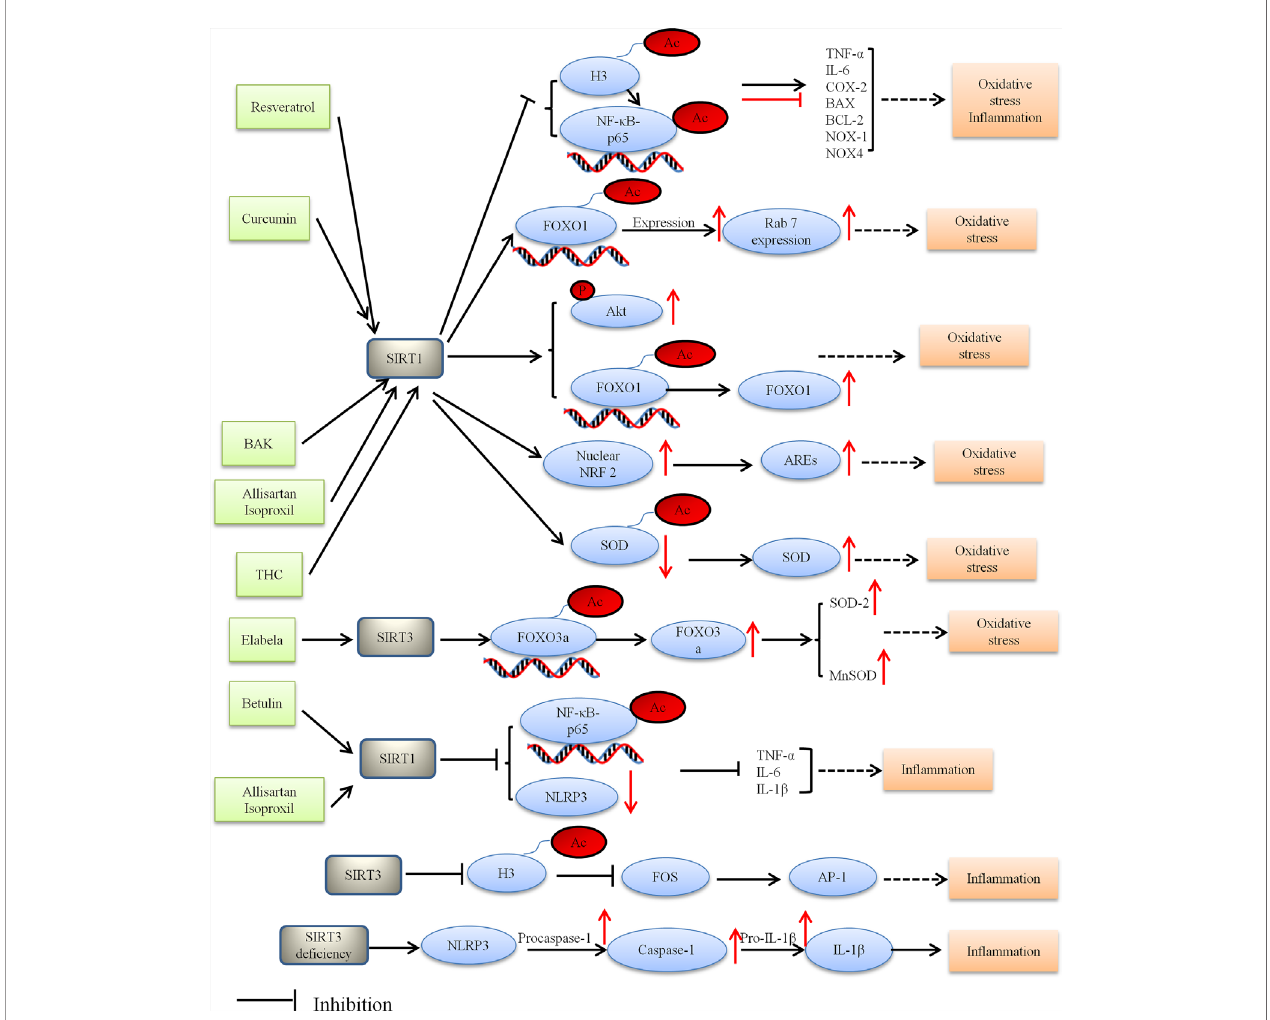
FIGURE 2 | Proposed model depicting regulation and the role of HDACs in oxidative stress and in fl ammation, and thus alleviating DCM. BAK, bakuchiol; THC, tetrahydrocumin, AREs, antioxidant-responsive elements; Ac, acetylation; P,